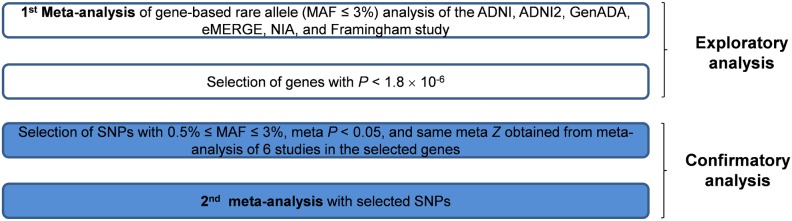
The overall scheme of this study.